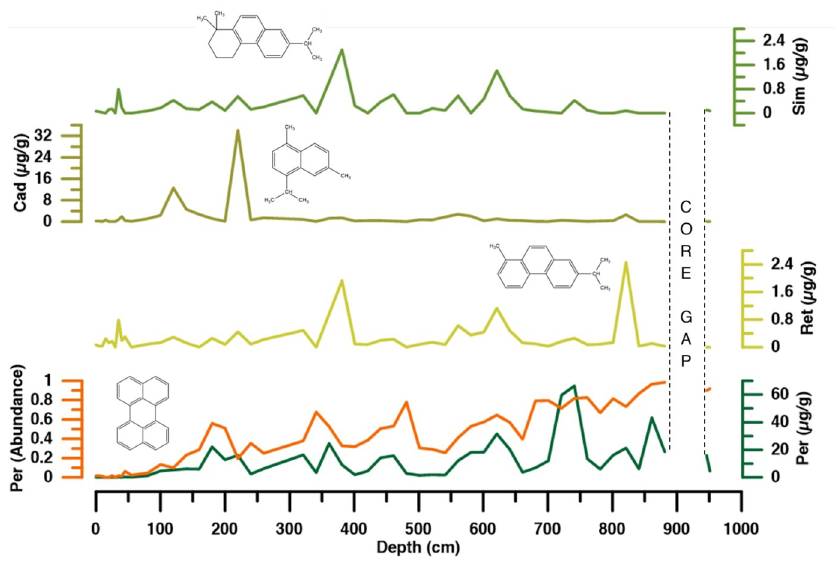
Fig 5. Depth variations in retene (Ret), perylene (Per), cadalene (Cad), and simonellite (Sim) concentrations.